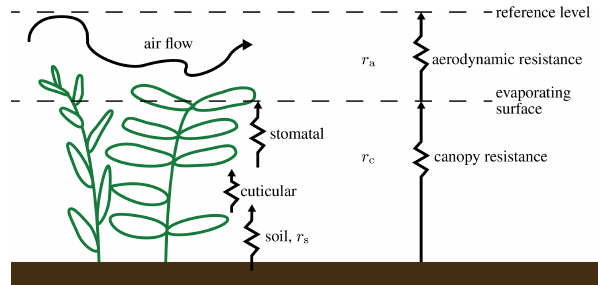
Figure 3. Diagram of the resistances encountered in a simplified soil–plant–atmosphere